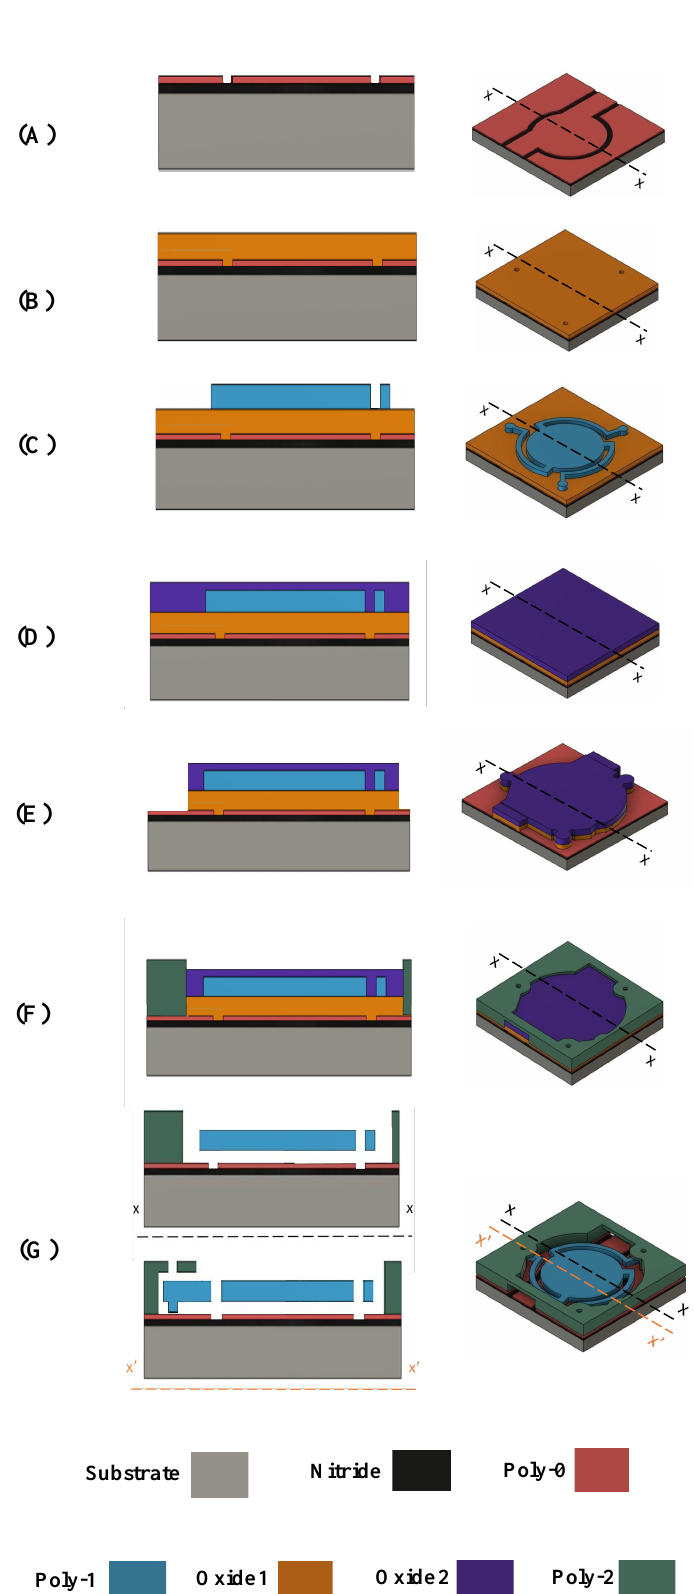
Figure 3. Cross-section x – x ( left ), and 3D ( right ) views of the different steps of the proposed fabrica- tion process